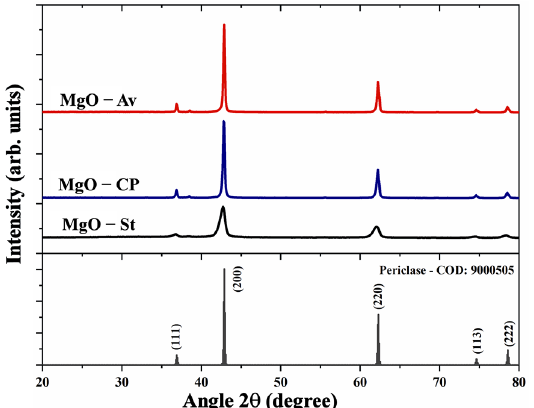
Figure 1. X-ray diffraction of the pattern Periclase [COD: 9000505] and the synthesized samples.